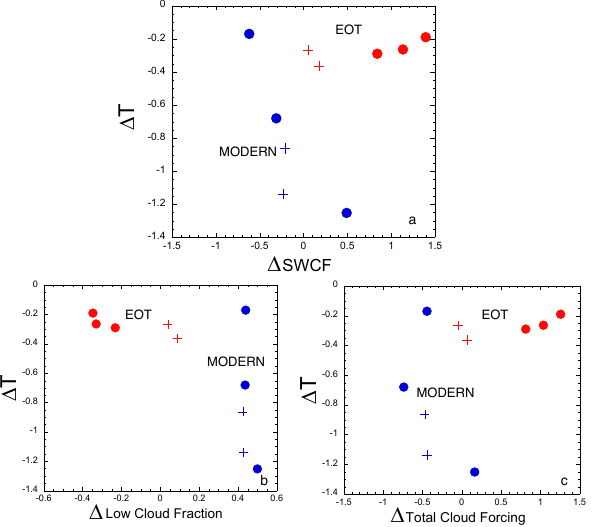
Fig. 9. Feedback related variables plotted with same conventions as Figure 8. Same colored dots and crosses described in Figure 4 (Table 1). a) The y-axis is the normalized SWCF feedback ( Wm -2 K -1 ) plotted against the mean annual temperature (MAT) of the unglaciated simulations using Eq. Fig. 5. (a) . The SWCF feedback (Wm − 2 K − 1 ) using Eq. (6) de- (11) described in section 3.2.1. b) Δ R LI Sea Ice clearsky along the y-axis compared against Δ T , c) anomalous sea ice area (m 2 ) compared against Δ T. scribed in Sect. 3.2.1 is plotted against the MAT of the unglaciated simulations. (b) The sea ice feedback (Wm − 2 K − 1 ) using Eq. (7) described in Sect. 3.2.1, plotted against the MAT of the unglaciated simulations, (c) 1 FSNSC SI compared with 1T , (d) anomalous sea ice area (1 × 10 6 m 2 ) plotted against 1T